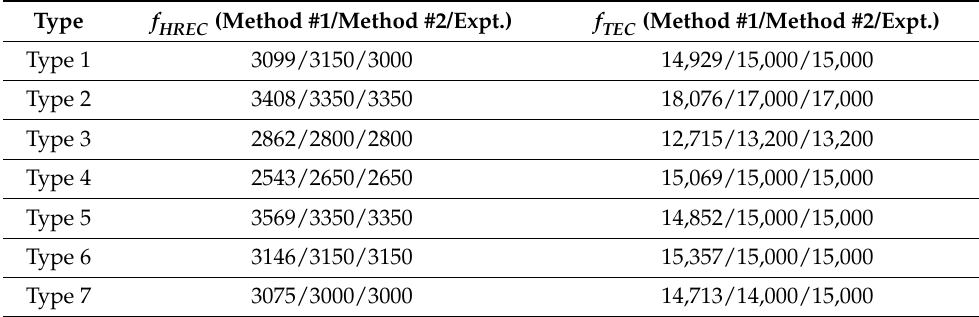
Figure 10. Different side-firing front chamber samples: ( a ) The side-firing chamber; ( b ) The differ- ent samples. Table 3. Peak frequencies comparison (All